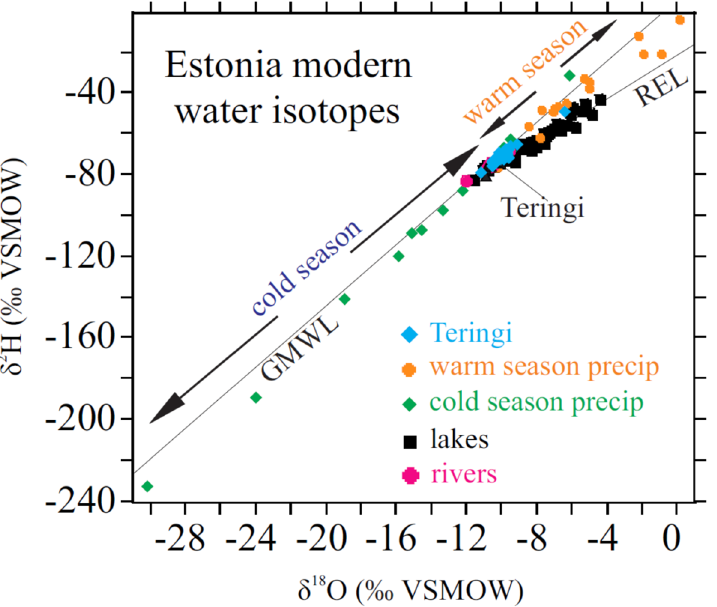
Figure 5. Modern water isotopes from Estonia plotted versus the global meteoric water line (GMWL). The Teringi Bog surface and well water samples plot near the GMWL, reflecting the isotopic composition of source precipitation and the water is a mix of both warm and cold season precipitation. Cold season precipitation samples have relatively low δ 18 O and δ 2 H values, while warm season values are higher. The regional evaporation line (REL), determined from closed-basin lakes in the area, is shown for comparison and plots well below the Teringi Bog surface and well water samples.